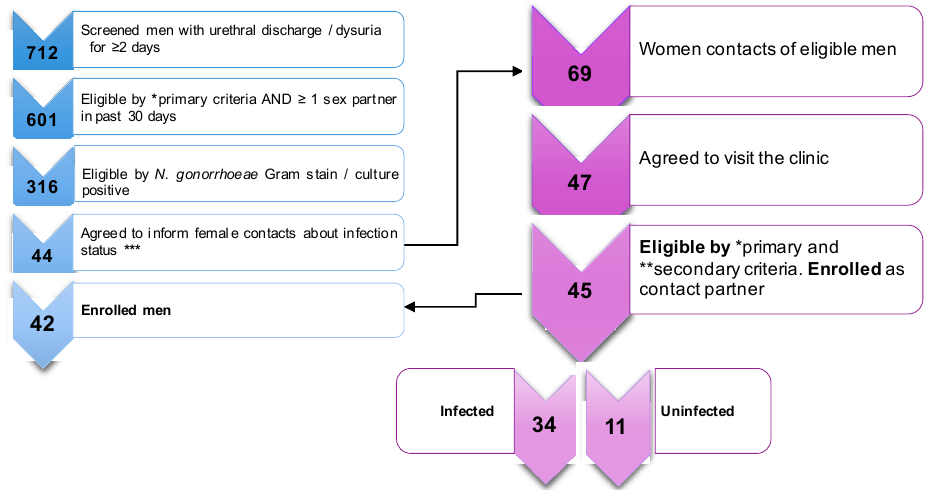
Figure 1. Neisseria gonorrhoeae cross sectional cohort enrollment scheme. Workflow describing number of screened, eligible, enrolled subjects, and N. gonorrhoeae infection status in enrolled women. Detailed primary and secondary criteria are also